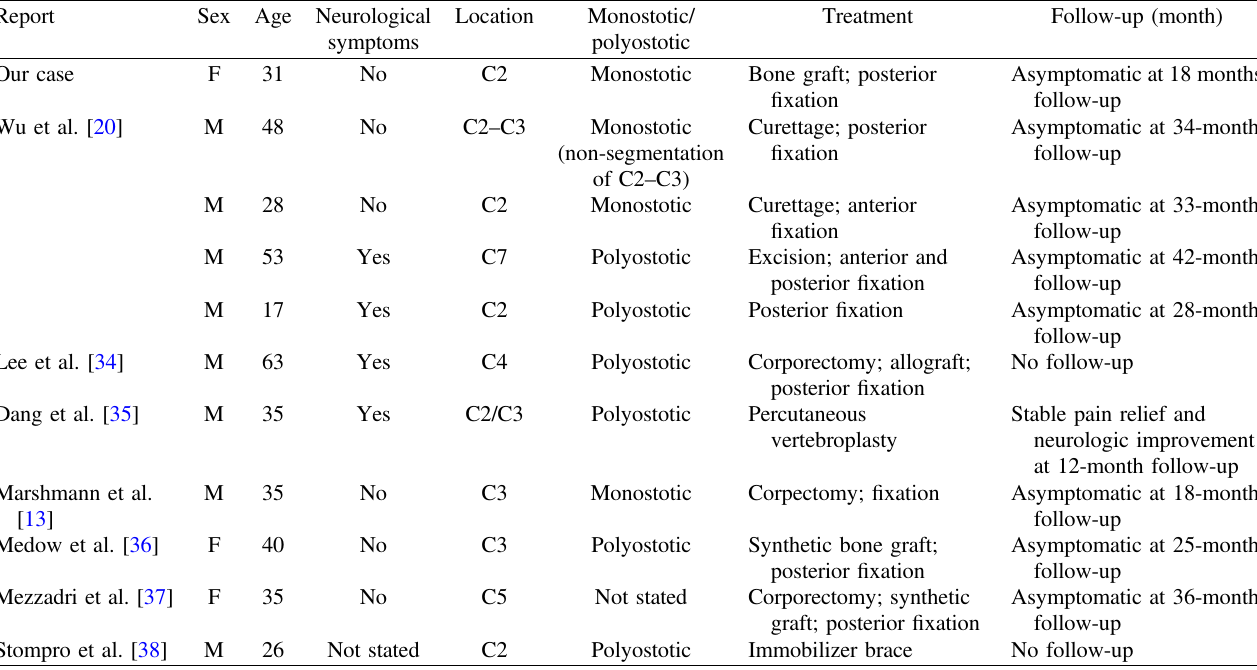
Table 1. Reported cases of cervical spine fi brous dysplasia presenting with a pathological fracture.